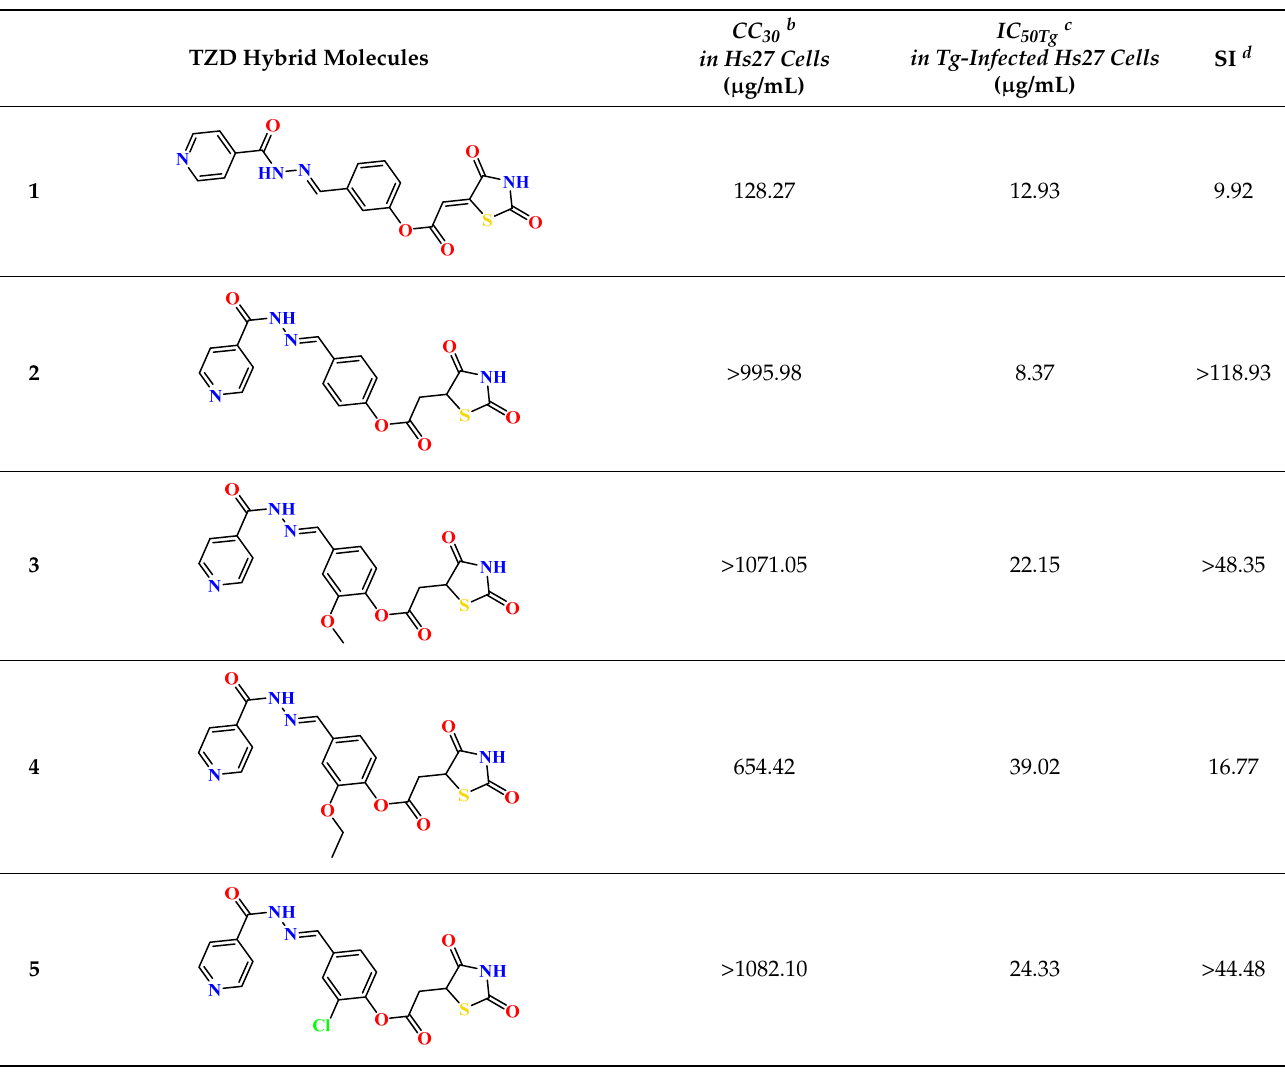
Figure 1. TZD-PCH ( 1 – 6 ) and TZD-TSC ( 7 – 12 ) hybrid molecules with promising anti- Mtb potency [43–45]. For the numbers used to identify the hybrid molecules ( 1 – 12 ), see Table 1. Table 1. Cytotoxicity (CC 30 ), anti- Tg activity (IC 50 Tg ), and selectivity index (SI) of TZD hybrid molecules ( 1 – 12 ) a .